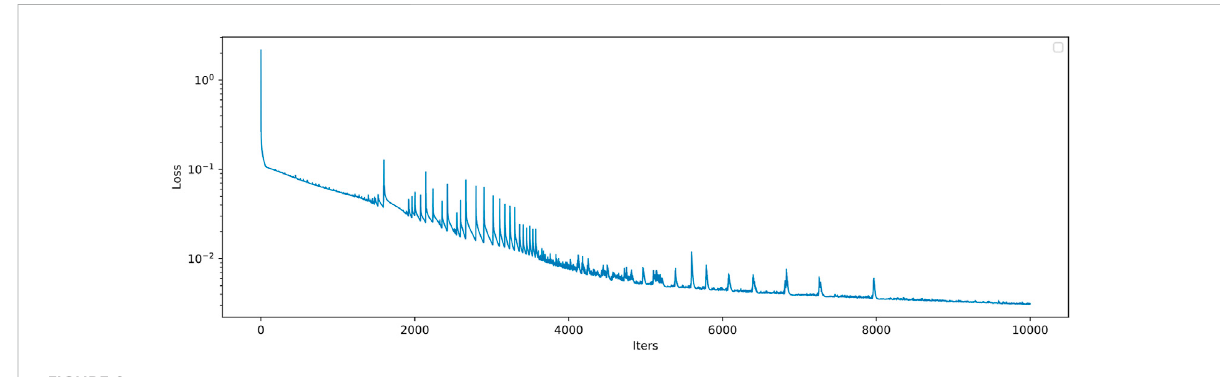
The convergence history of Fourier fi lter-based